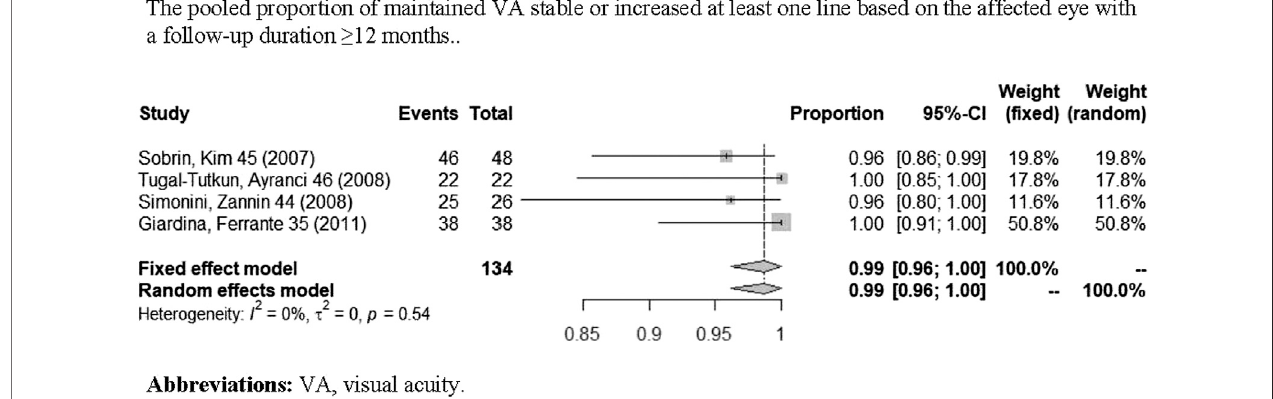
FIGURE 6 | Pooled proportion of maintained VA stable or increased at least one line based on the affected eye with a follow-up duration of ≥ 12 months.